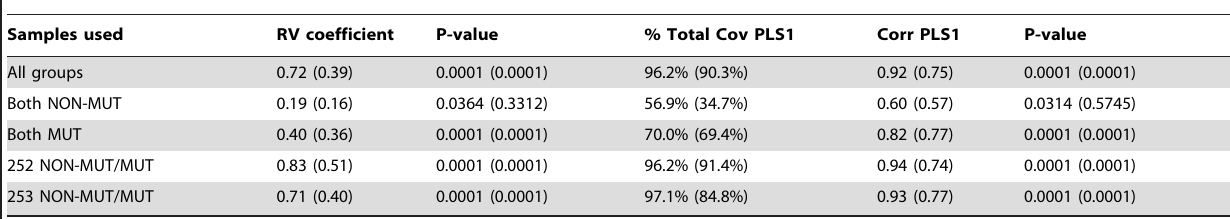
Table 1. Results of PLS